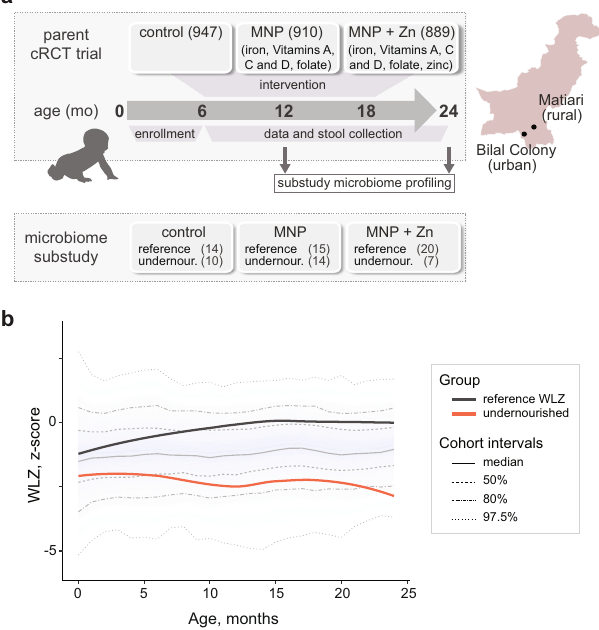
Fig. 1 Schematic of the parent micronutrient supplementation trial and participant characteristics selected for microbiome pro fi ling. a The timeline of the parent cRCT (ClinicalTrials.gov identi fi er NCT00705445), including enrollment, intervention, and follow-up. Urban and rural study sites are shown on the right. Numbers of participants recruited into each of the three intervention arms of the parent trial are indicated in brackets. A subset of participants, undernourished (WLZ < − 2) and a reference comparator group (WLZ > − 1), were selected from each arm for retrospective microbiome pro fi ling, as shown. See Supplementary Fig. 1 for details of participant selection. b Weight-for-length z-scores of children recruited into clinical trial NCT00705445 during the fi rst 24 months of life. Median and quantile values are shown, with medians for participants pro fi led in the current study indicated by red (undernourished) and black (reference WLZ)